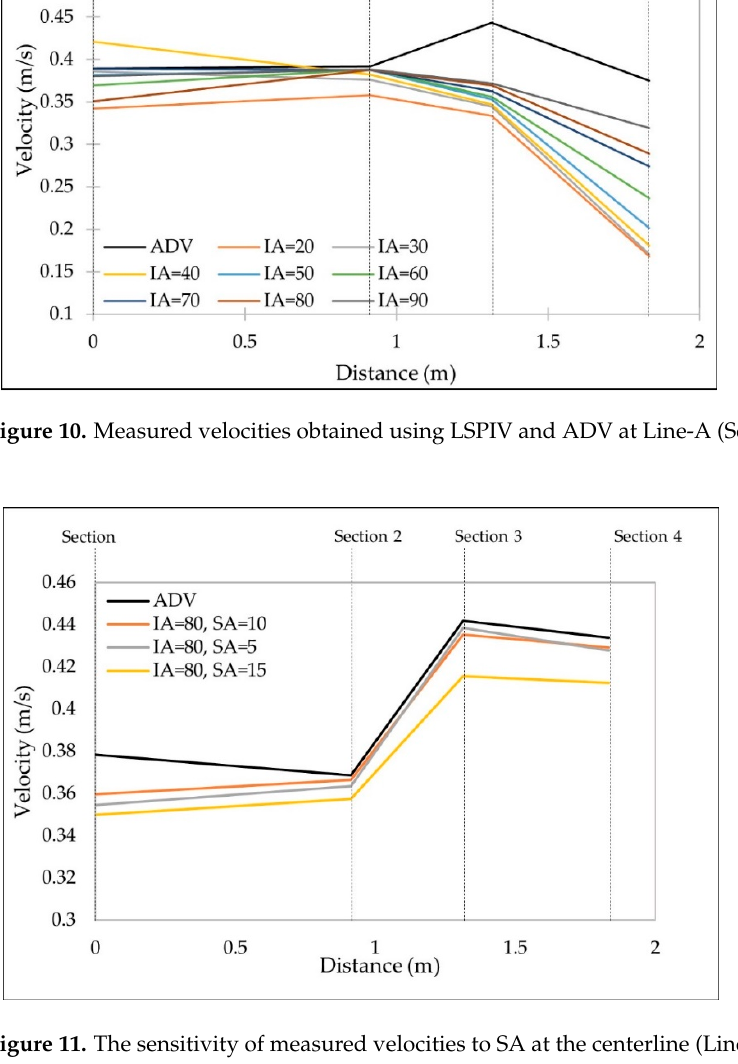
Figure 11. The sensitivity of measured velocities to SA at the centerline (Line-D).